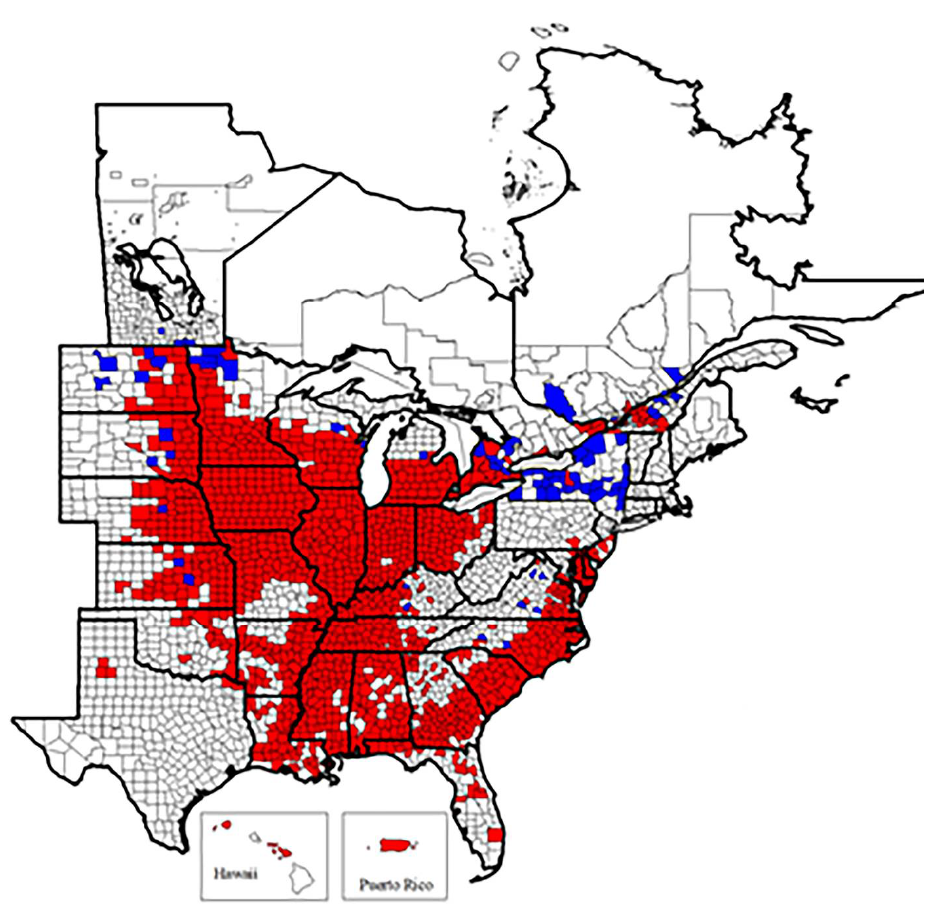
Figure 6. Continental U.S. distribution of Heterodera glycines (source, Tylka and Marett, courtesy of Plant Health Progress) [9].